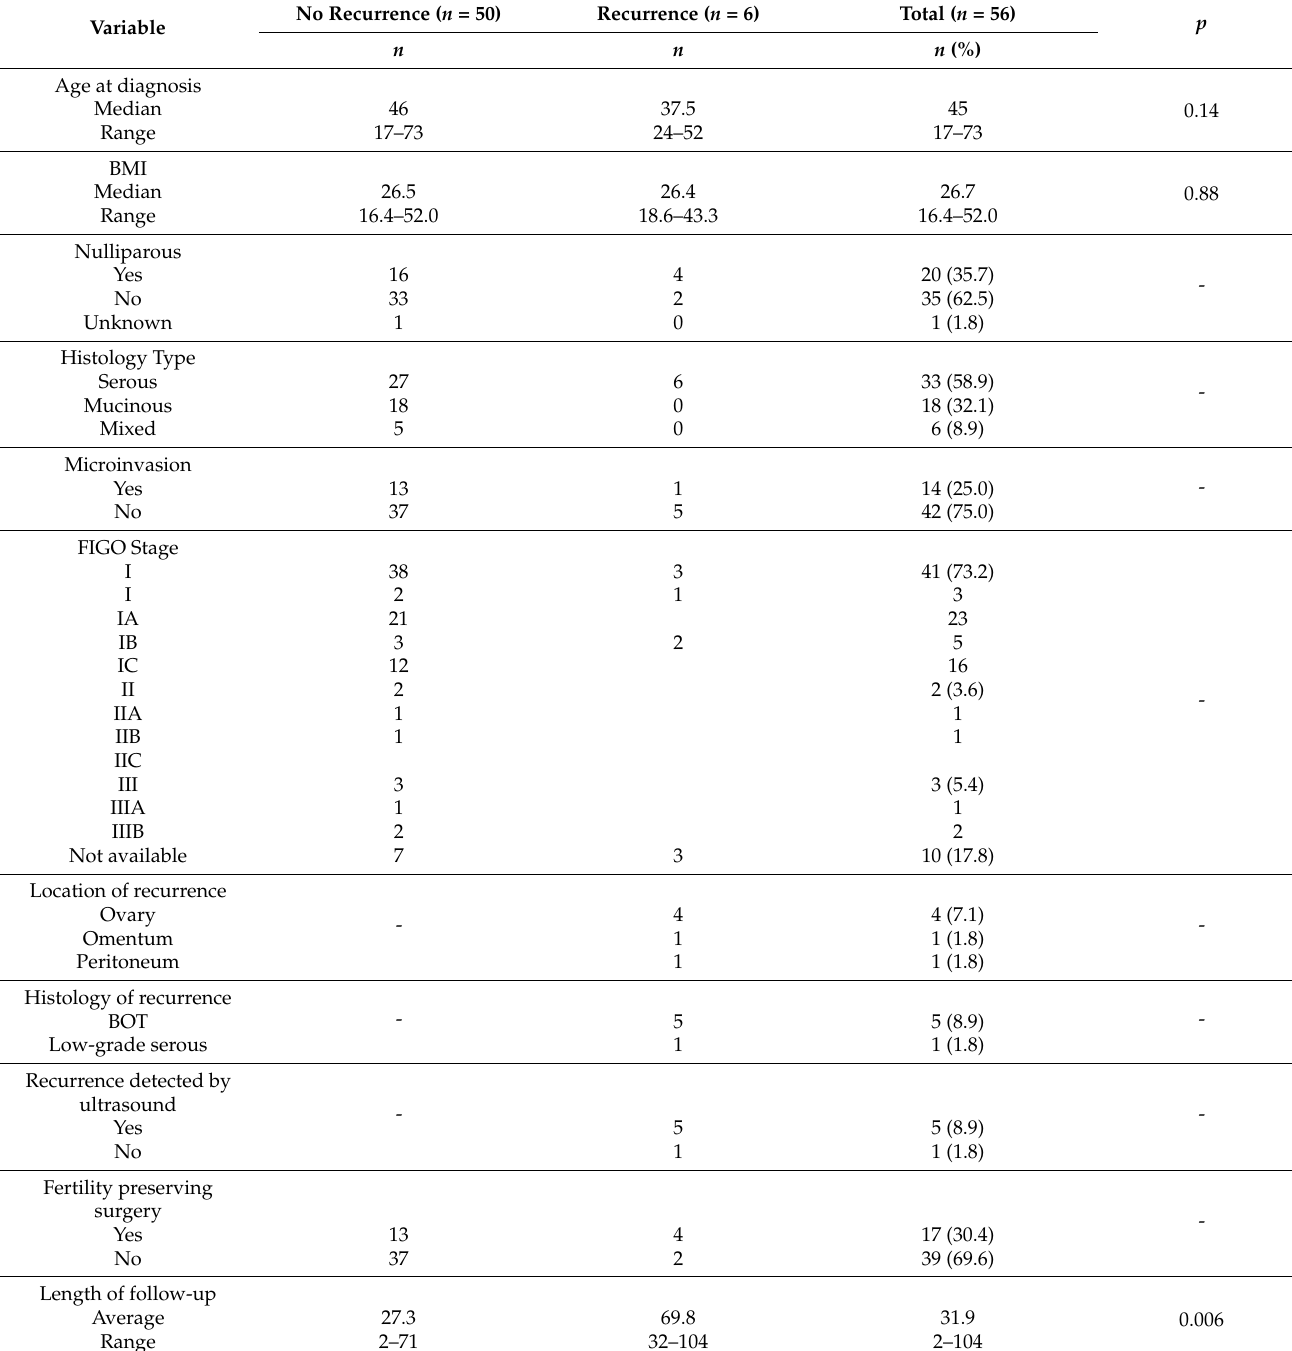
Table 1. Baseline